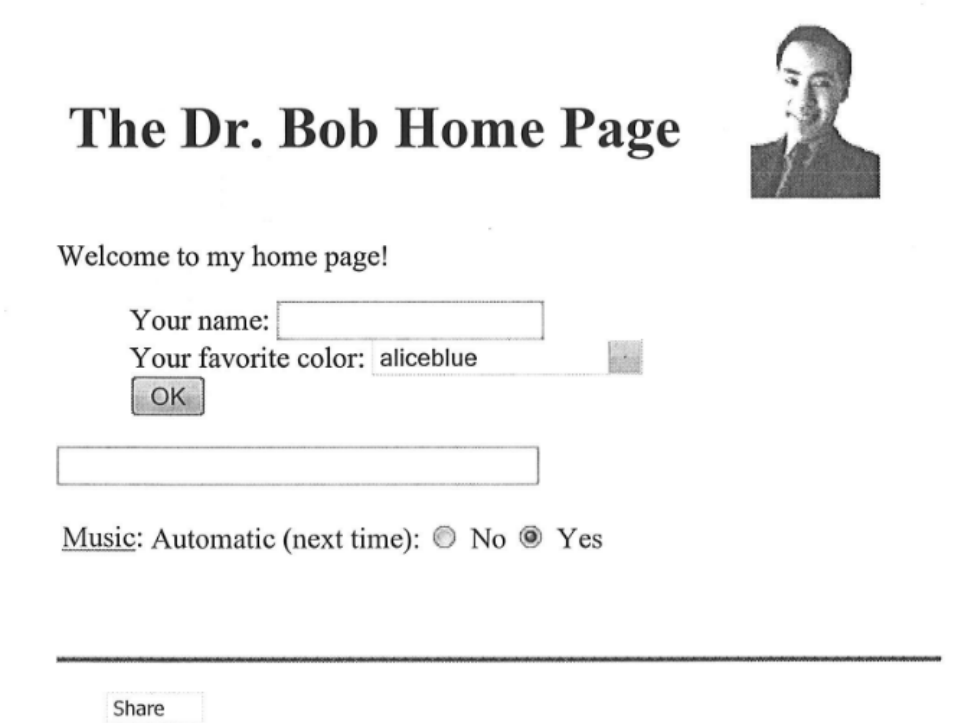
Figure 2. Screenshot of Psycho-Babble home